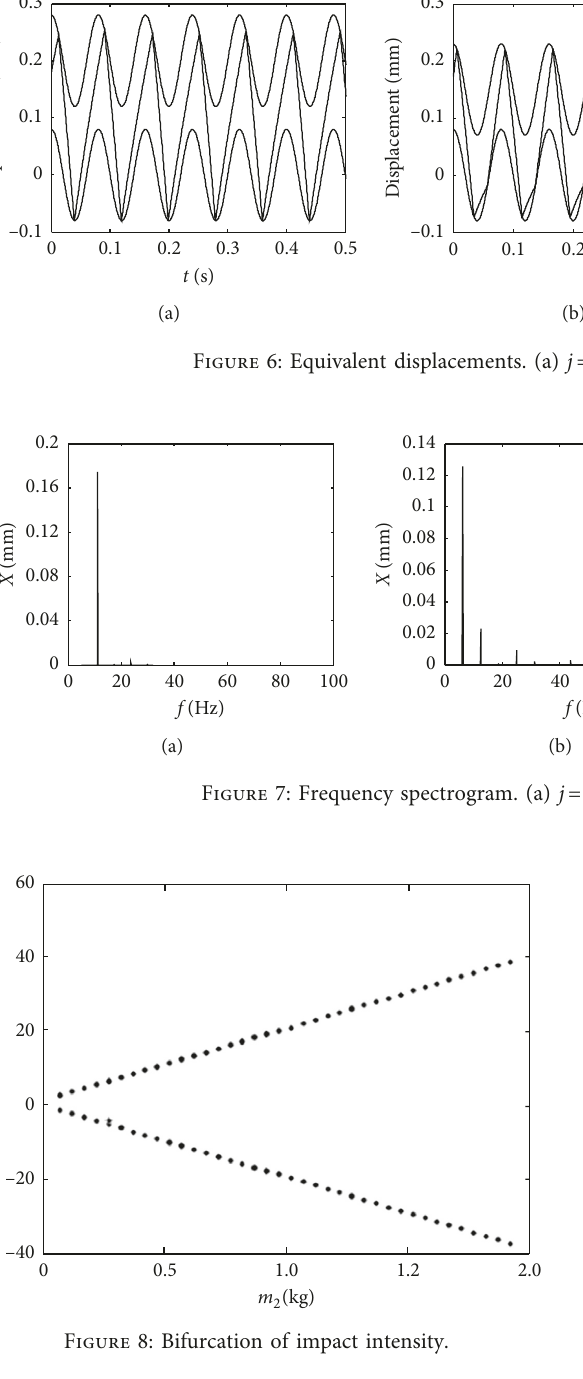
Figure 8: Bifurcation of impact intensity. Figure 9: Bifurcation of equivalent